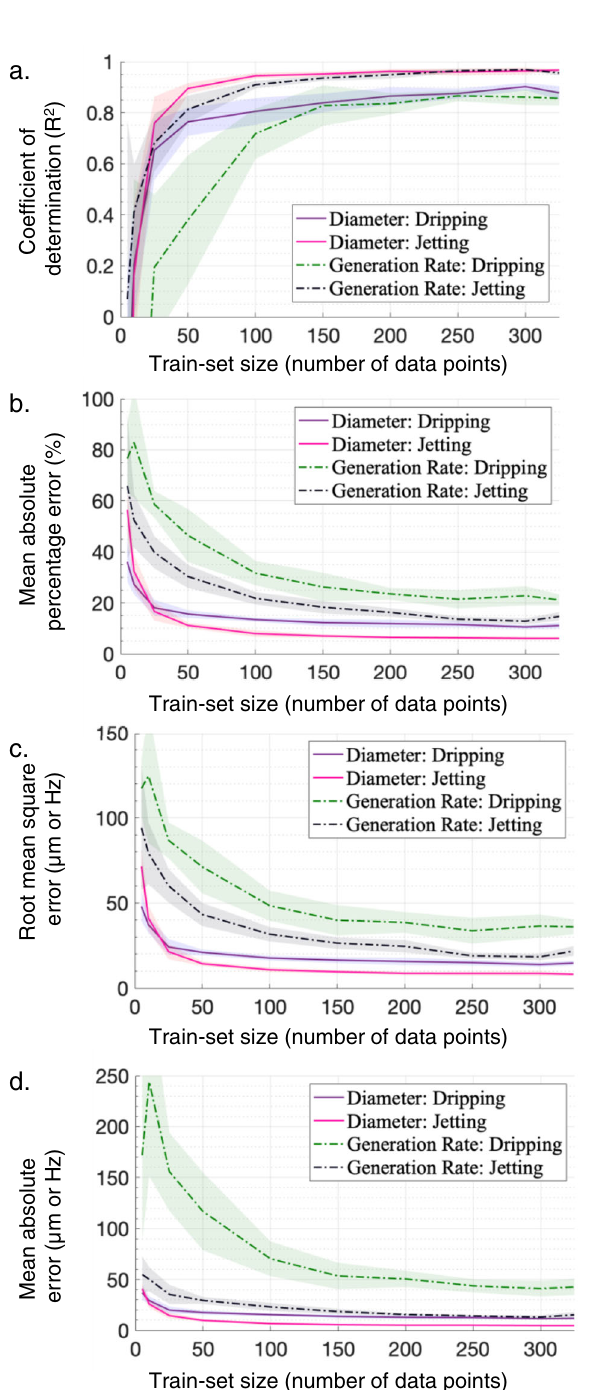
Fig. 4 Effect of data-set size on the accuracy of performance